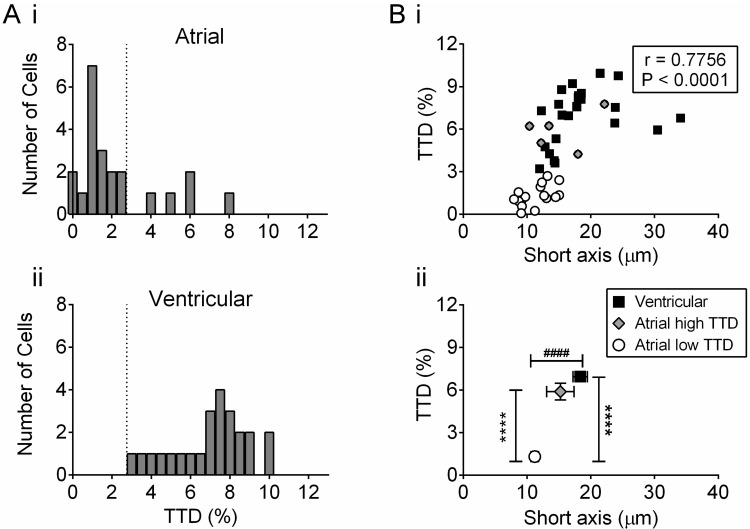
Distribution of t-tubule density in atrial and ventricular cells from tissue sections.A) Frequency distributions of, respectively, atrial (i) and ventricular (ii) myocyte t-tubule density. B) Correlation of t-tubule density with short axis diameter. (i) Data shown separately for atrial cells with ‘low TTD’ (open circles, n = 17), in atrial cells with ‘high TTD’ (grey-filled diamonds, n = 5) and in ventricular cells (black-filled squares, n = 24). Spearman’s correlation coefficient is shown (n = 46). TTD was correlated with short axis diameter for both atrial cells (r = 0.6025, P = 0.0030, n = 22) and ventricular cells (r = 0.4887, P = 0.0154, n = 24). (ii) Data shown as mean±SEM for each cell type. ** P<0.01, *** P<0.0001 one-way ANOVA with Bonferroni post-test for TTD. ## P<0.01, ### P<0.0001 one-way ANOVA with Bonferroni post-test for short axis diameter. Data were obtained from atrial and ventricular sections obtained from 3 pigs for either cell type.